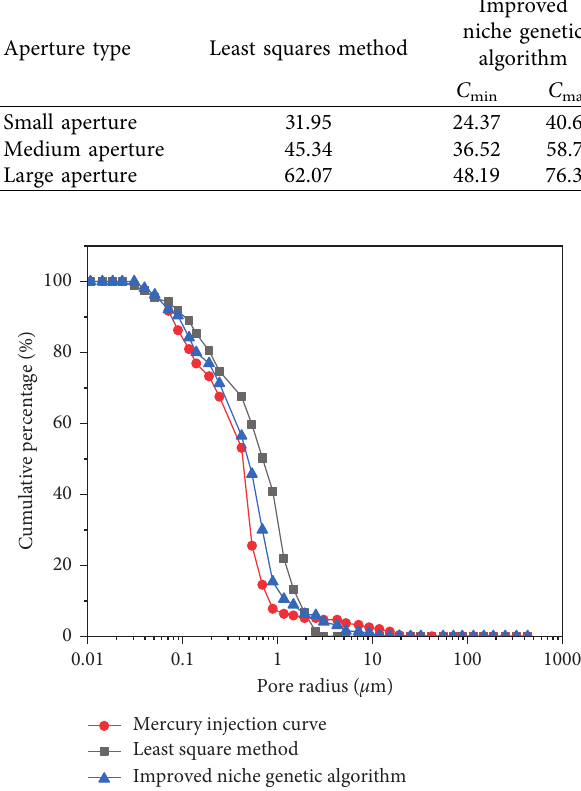
Figure 3: Comparison of T 2 spectrum conversion curves (according to the data in Figure 1 in [9], it was redrawn with the new algorithm in the manuscript).